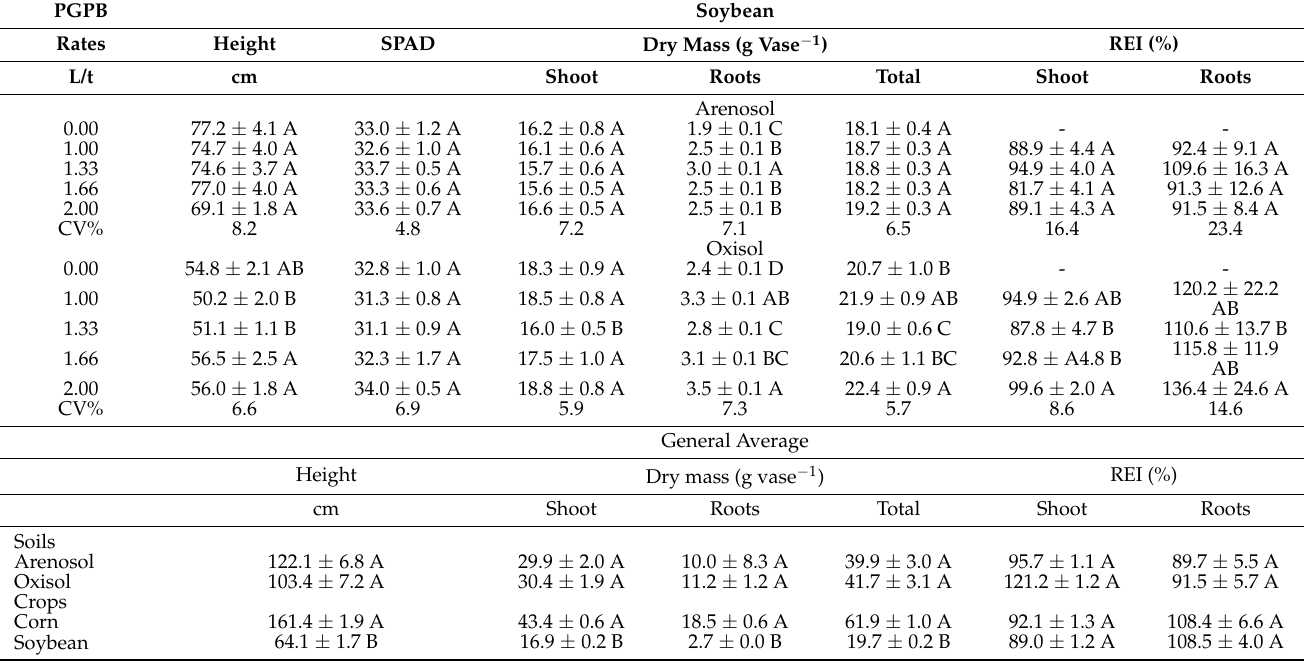
CV: coefficient of variation; averages with the standard error; uppercase letters represent the comparison between treatments (PGPB rates) using the Duncan test ( p -value < 0.05). The general averages of soils and crops were tested by the t -test ( p -value < 0.05). Control is the application of monoammonium phosphate without